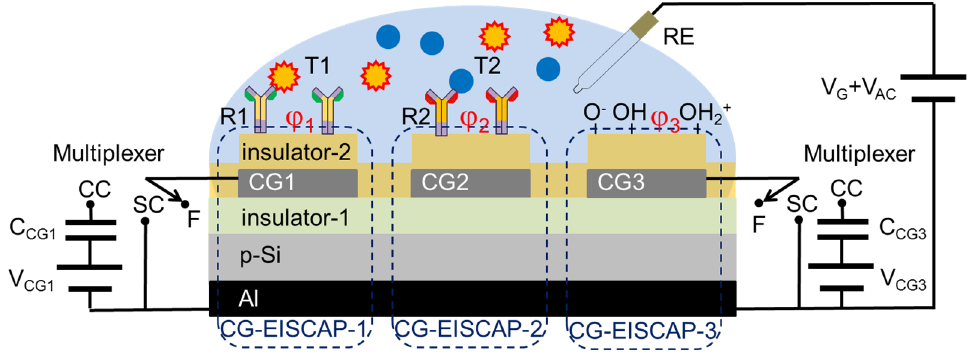
Figure 2. Schematic structure of the designed sensor chip for detecting multiple analytes, combining an array of three individually addressable CG-EISCAPs and measurement setup. RE: reference electrode (sensing gate, SG); V G : gate voltage; V AC : alternating current voltage; Al: rear-side contact; CG1, CG2 and CG3: control gates; position “F”: floating; position “SC”: short-circuited; position “CC”: capacitively-coupled; C CG1 and C CG3 : control gate capacitances; V CG1 and V CG3 : voltage applied to the control gate; R1 and R2: receptors; T1 and T2: target species to be detected; ϕ 1 , ϕ 2 and ϕ 3 : potential at the insulator-2/electrolyte interface related to CG-EISCAP-1, CG-EISCAP-2 and CG-EISCAP-3, respectively. For better visibility, the multiplexer for CG-EISCAP-2 is not shown.